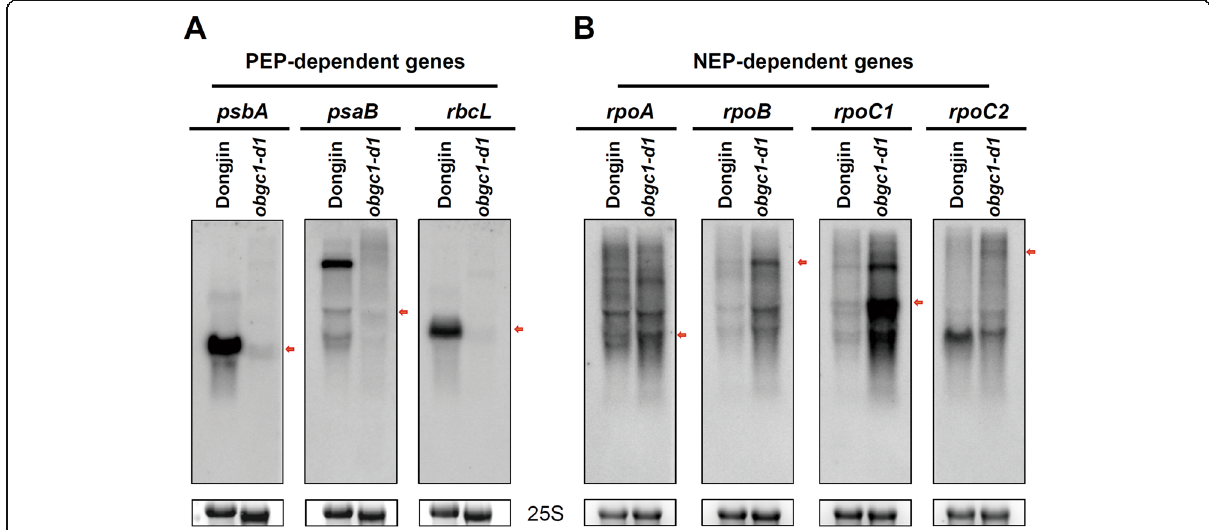
Fig. 7 Transcription profiles of chloroplast-encoded genes in rice obgc1-d1 mutants. Total RNAs (20 μ g) extracted from leaves of 10-day-old obgc1-d1 mutant and wild-type Dongjin seedlings were subjected to northern blot analysis using the indicated gene-specific probes. A and B indicate the transcription profiles of PEP- and NEP-dependent chloroplast genes in the wild-type and obgc1-d1 mutant, respectively. The expression levels of 25S were used as the internal control. The mature transcripts of the corresponding genes were indicated with red arrows